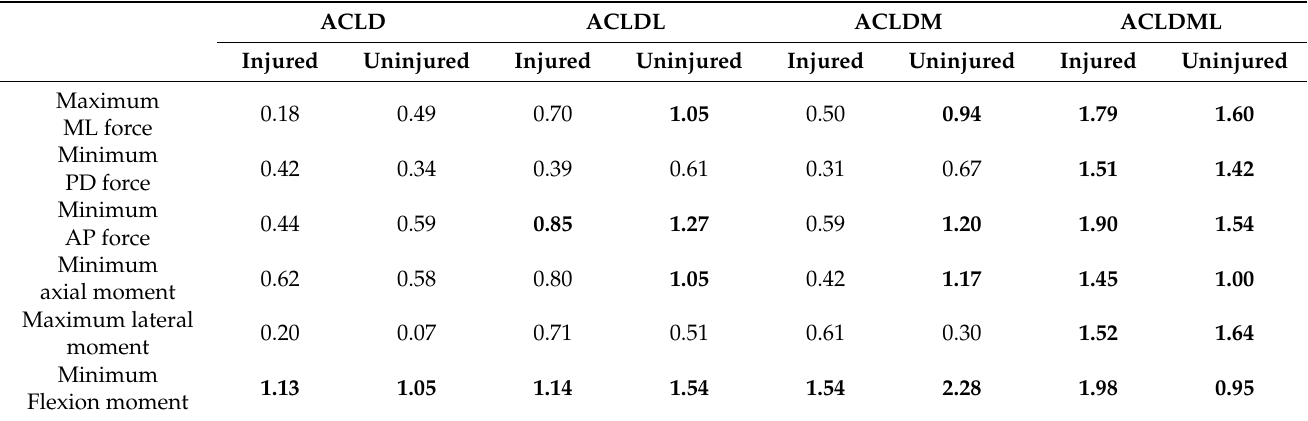
Table 2. The absolute value of Cohen’s d effect size compared to the control group *.